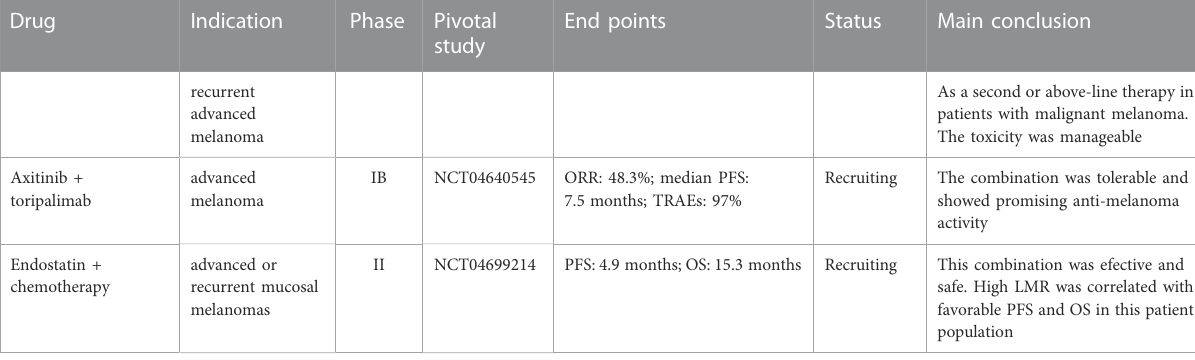
TABLE 2 ( Continued ) Overview of clinical studies in melanoma cancer of anti-angiogenic therapy.